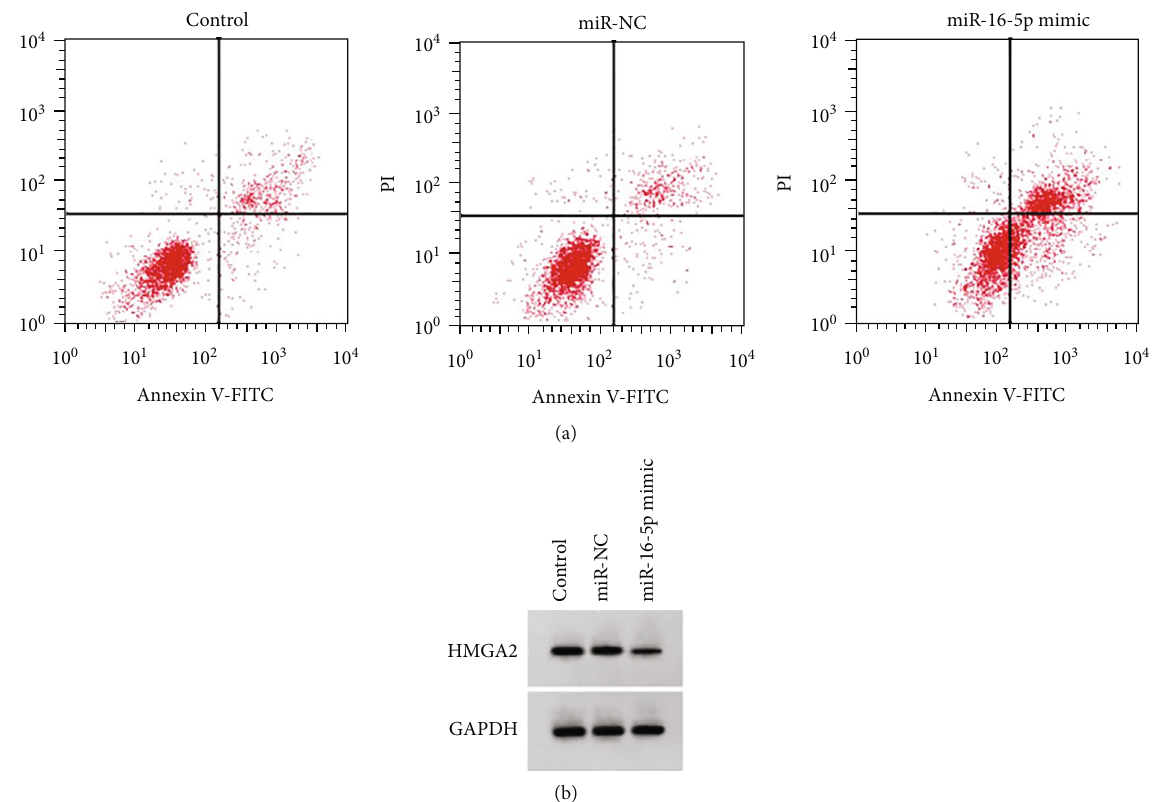
Figure 4: E ff ect of overexpression of miR-16-5p on apoptosis and HMGA2 protein expression of DU145